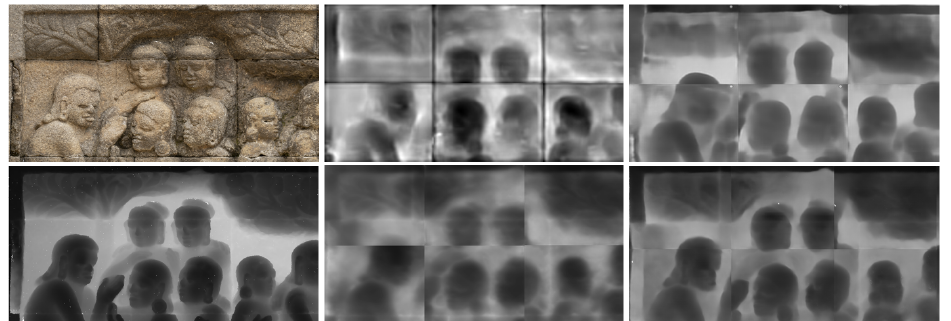
Figure 16. The comparison results of the depth estimation results between the proposed method and the other models. From top left to bottom right: the monocular photo, the result of CNN [21], the result of ResNet-50 [22], the ground truth, the result of DenseDepth [42], and the result of the proposed method